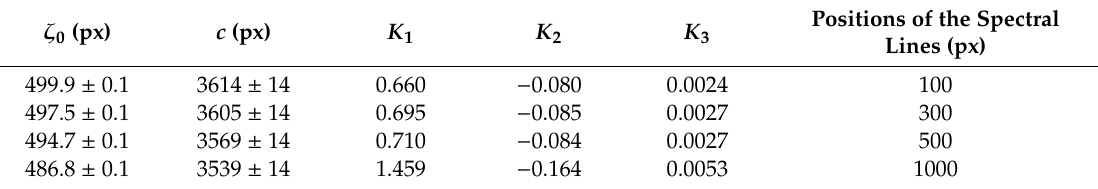
Table 2. Internal orientation elements for positions of the spectral lines of 100, 300, 500 and 1000